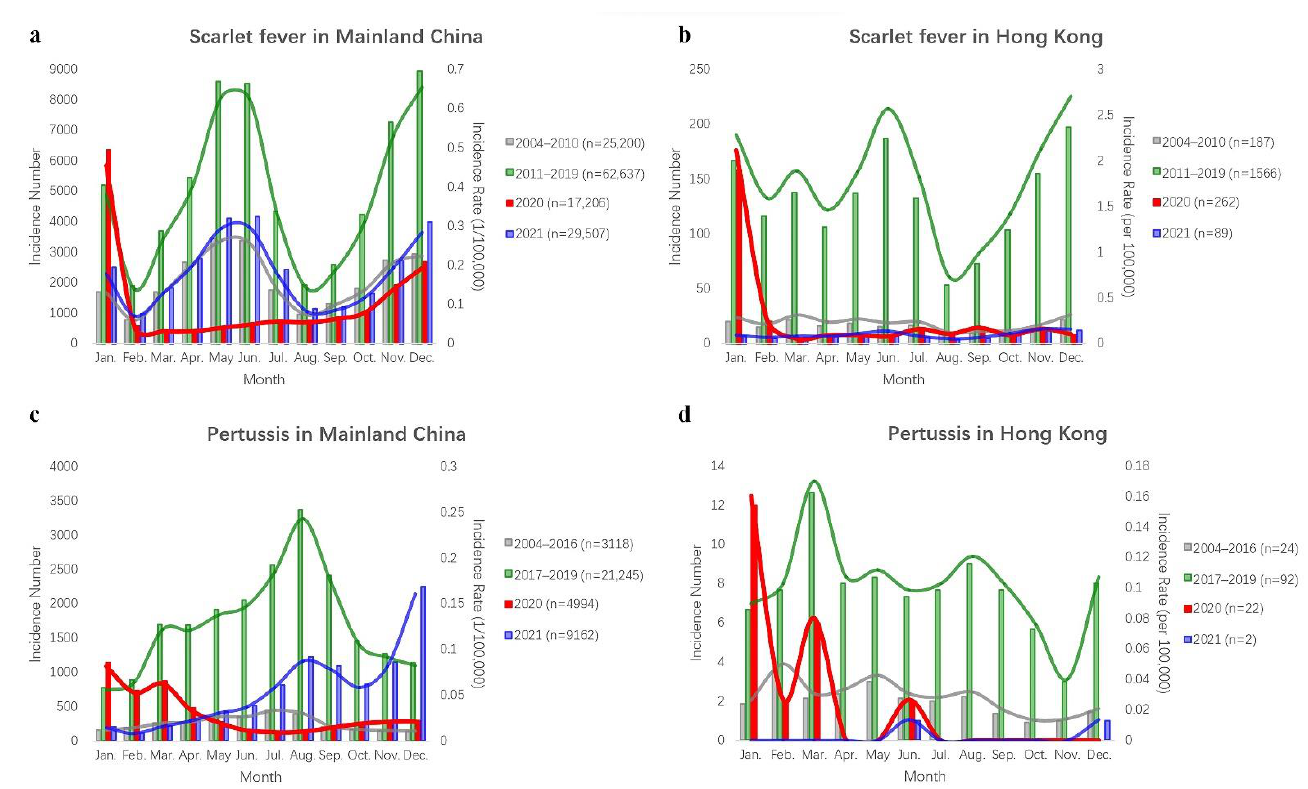
Figure 3. Comparison of monthly incidence rates (1/100,000) of scarlet fever and pertussis.